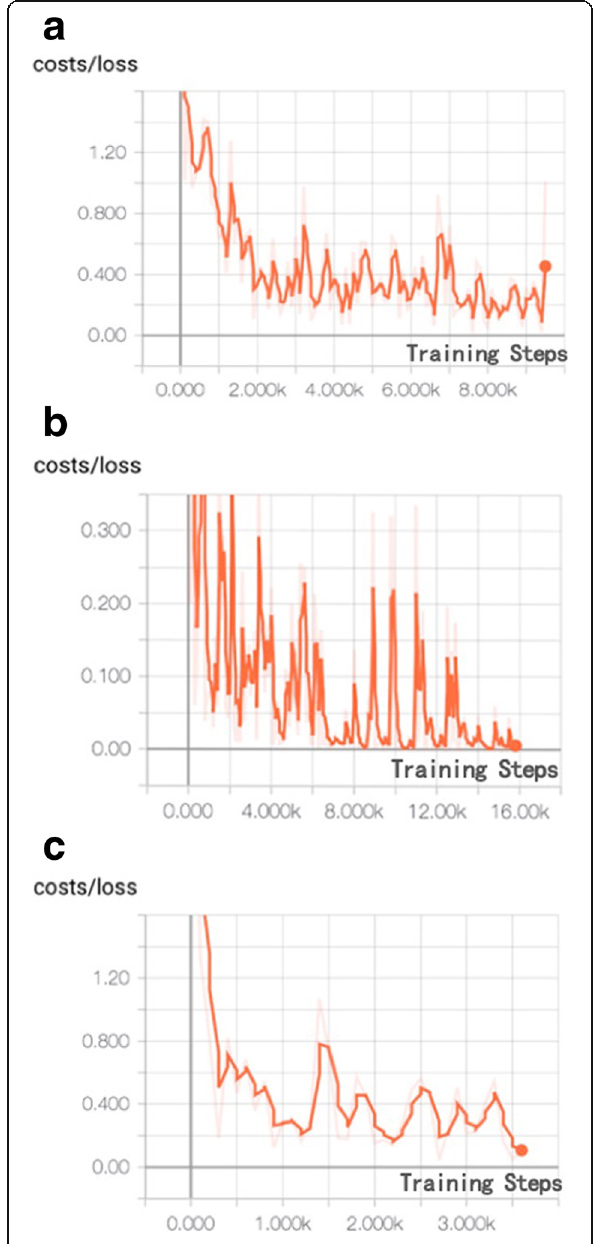
Fig. 4 Loss function curves of data of tomato, potato and corn